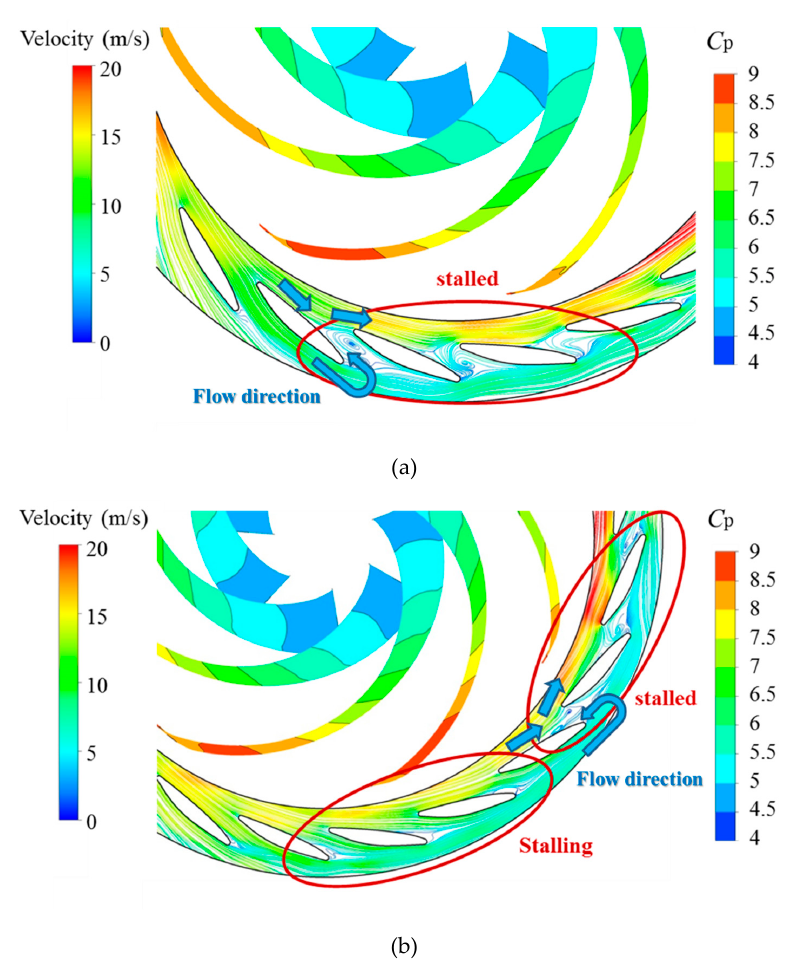
Figure 17. Instantaneous streamlines in the guide vane channels and pressure distributions on the pressure side of impeller at condition ( a ) IV and ( b ) III.